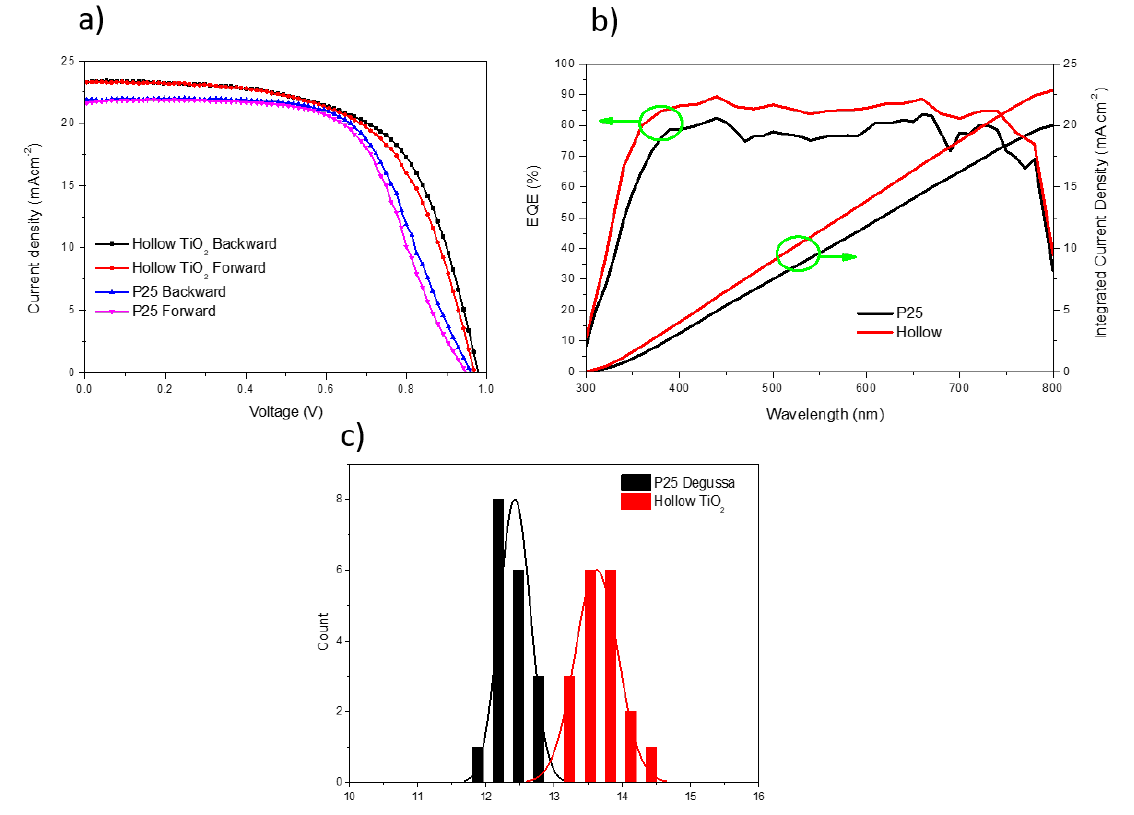
Figure 9. ( a ) J -V curves of the P25 and TiO 2 hollow nanosphere-based PSCs. ( b ) External quantum efficiency of the P25 (hollow)-based devices and integrated current density. ( c ) PCE distributions of the 36 cells of the P25 and TiO 2 hollow nanosphere-based